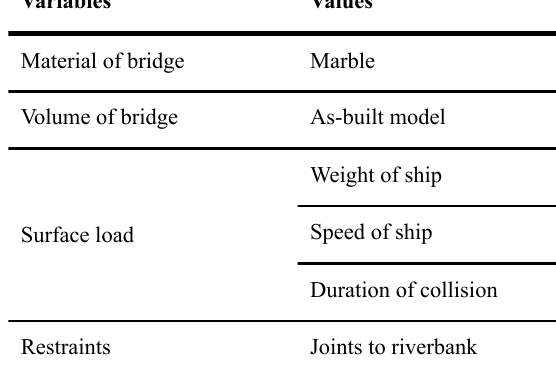
Table 1. Variables and values for structural analysis